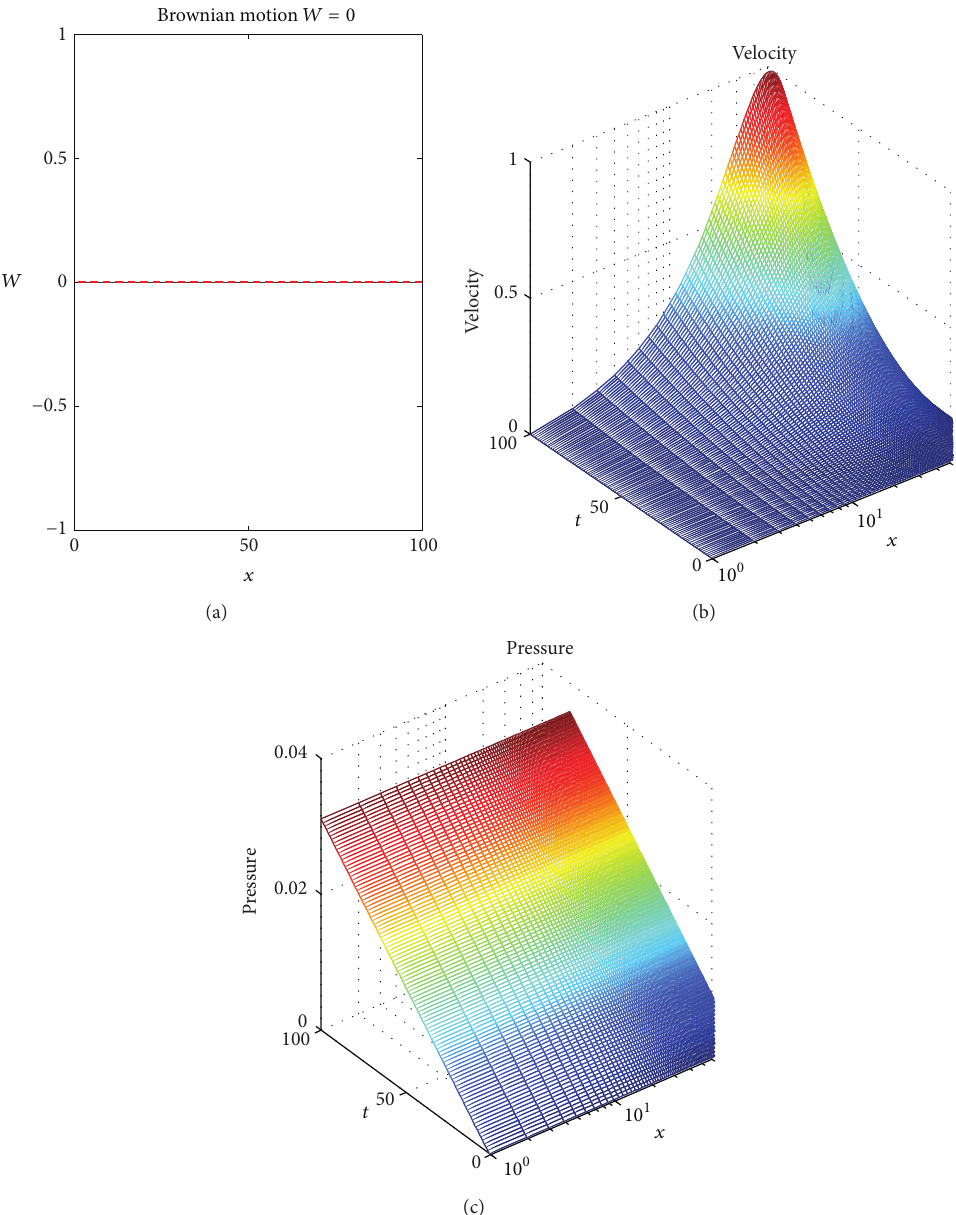
Figure 1: A null Brownian motion and the associated velocity and